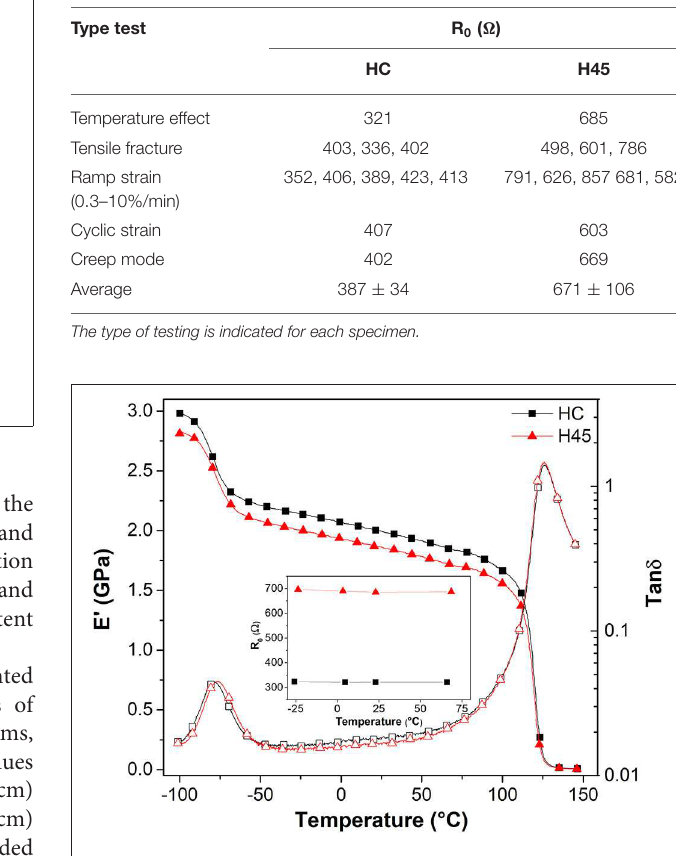
FIGURE 4 | DMA analysis of samples for evidencing the main viscoelastic properties of samples at a different temperature, and resistance of HC and H45 3D-printed parts in the range − 20 and + 60 ◦